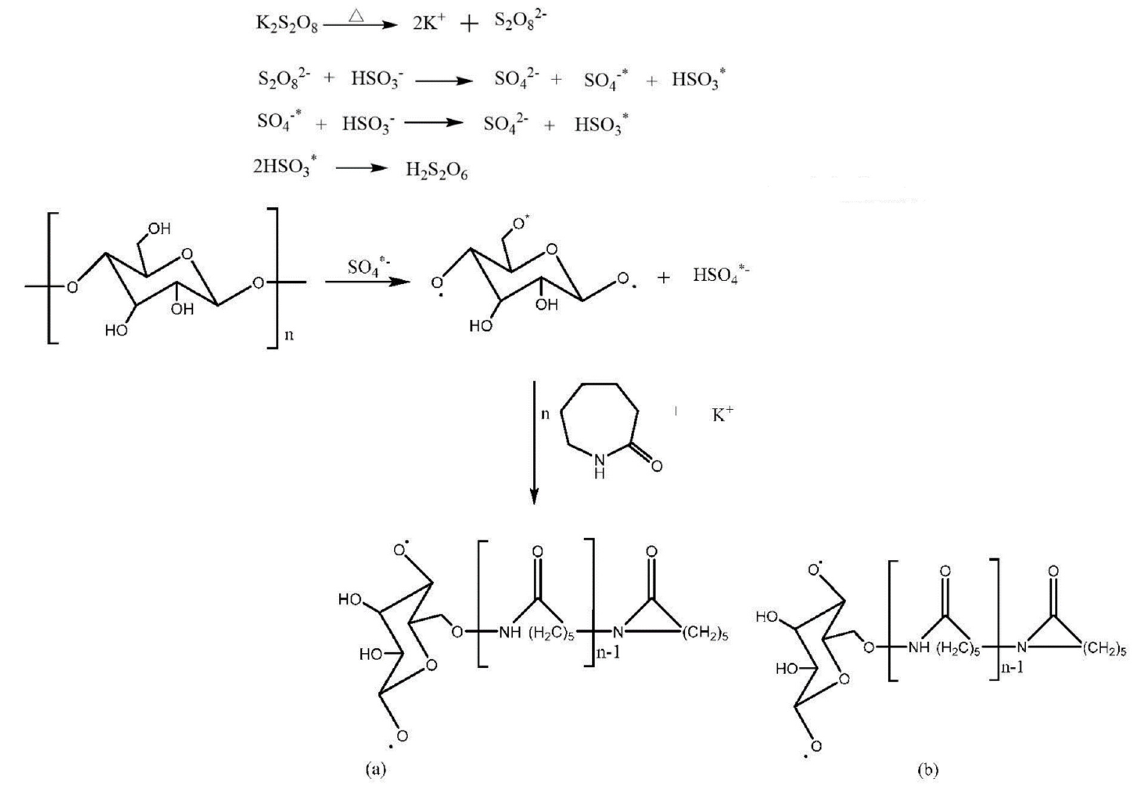
Figure 1. Synthesis scheme and polymer molecular structure diagram. Chain growth reaction mechanism shown in Figure 2 [40].